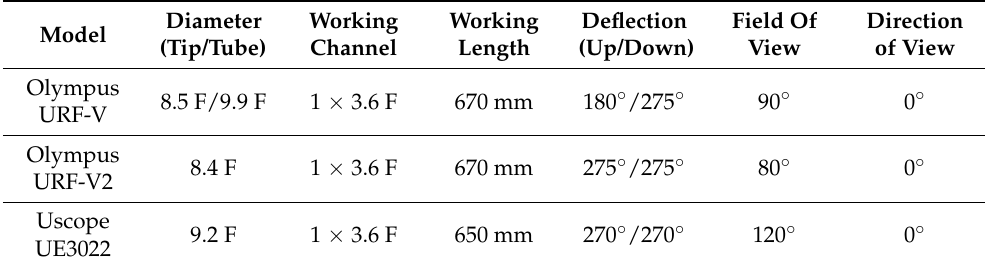
Table 1. Main technical features of the three studied models of flexible ureteroscopes (data provided by the